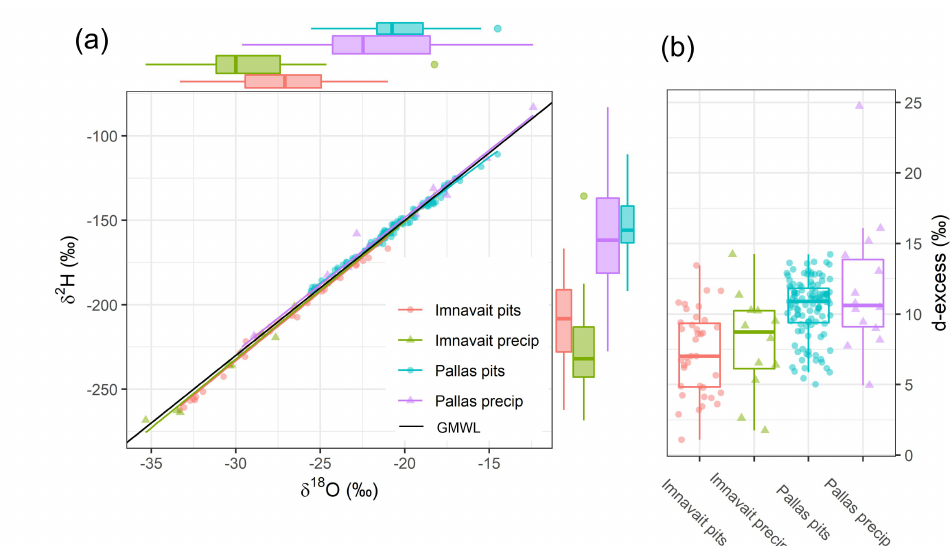
Figure 3. ( a ) Dual isotope plot with side panel boxplots and regression lines, and ( b ) boxplots for d-excess values for snow pit and precipitation samples for Imnavait and Pallas. Note how water line plots depict the generally colder conditions in North Alaska and the lower isotope composition compared to those at Pallas. Slopes and standard errors for regression equations are Imnavait pits: 8.14 ± 0.14, Imnavait precip: 8.13 ± 0.28, Pallas pits: 7.46 ± 0.07, Pallas precip: 7.95 ±